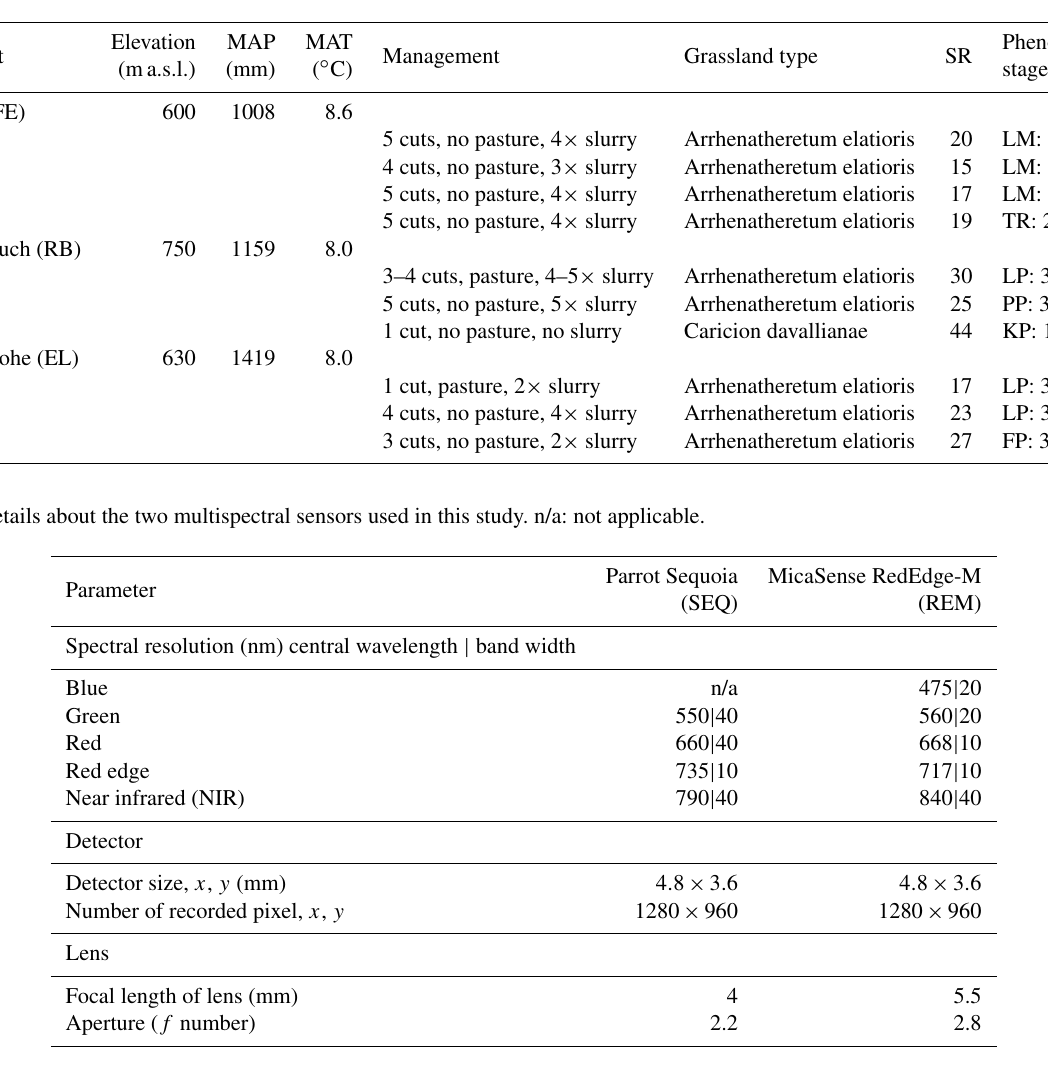
Table 1. Site and plot characteristics partly taken from Schucknecht et al. (2020a). Mean annual climate parameters (MAP: mean annual pre- cipitation height, MAT: mean annual temperature) were derived from the DWD Climate Data Center (DWD Climate Data Center, 2019a, b) and correspond to the period 1981–2010. Grassland type and species richness (SR; i.e. number of vascular plant species) were obtained by a species inventory in 2020 (Schuchardt and Jentsch, 2020). The phenological stage was determined by inspecting the photos of the plots with respect to the dominant species (species abbreviated as LM for Lolium multiflorum , TR for Trifolium repens , LP for Lolium perenne , PP for Poa pratensis , KP for Koeleria pyramidata , and FP for Festuca pratensis ). Provided is the number of the principle growth stage (1: leaf development (main shoot), 2: formation of side shoots/tillering, 3: stem elongation or rosette growth/shoot development (main shoot), 4: de- velopment of harvestable vegetative plant parts or vegetatively propagated organs/booting (main shoot)) according to the BBCH (Biologische Bundesanstalt für Land- und Forstwirtschaft, Bundessortenamt und Chemische Industrie) classification (Meier, 2018).